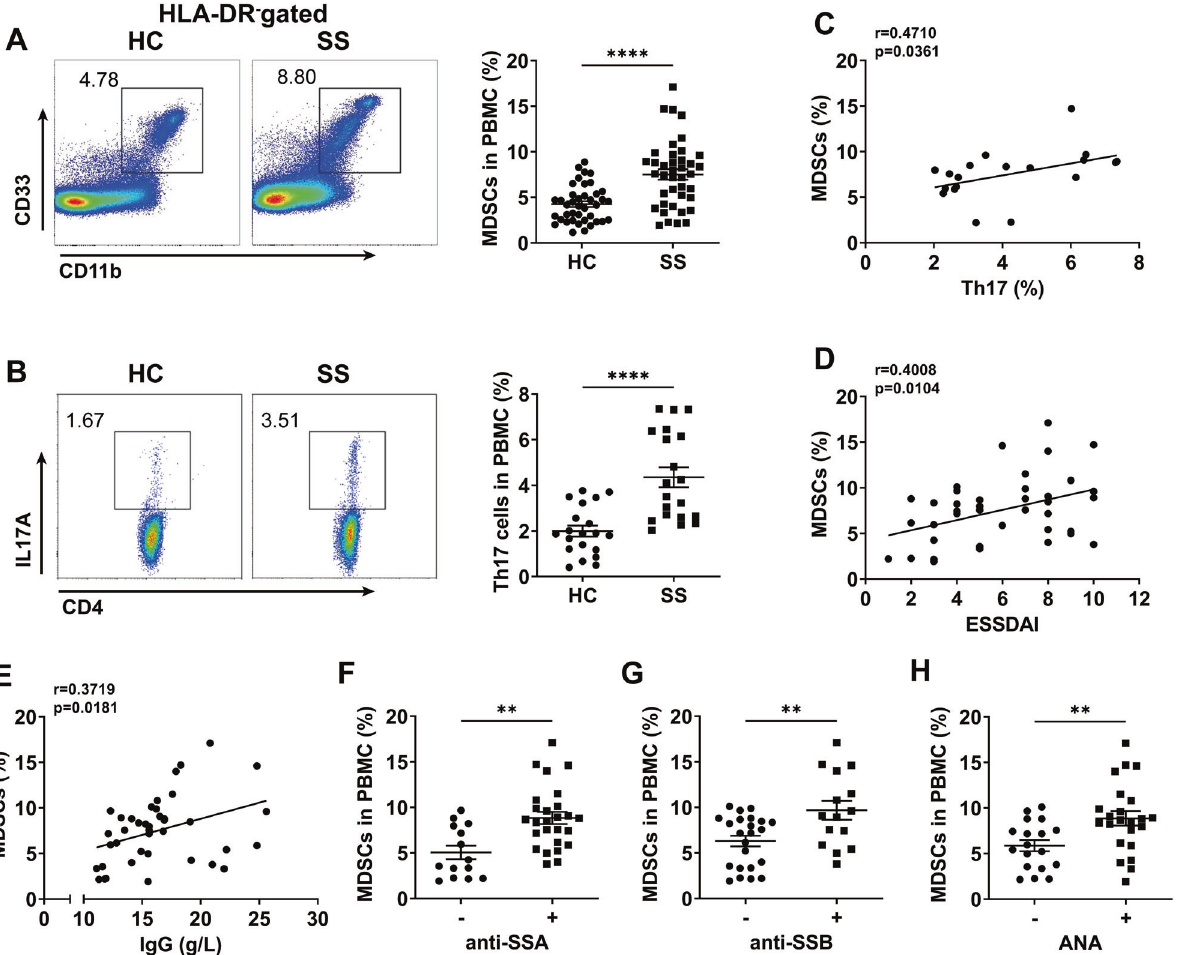
Fig. 1 Peripheral MDSCs from SS patients were positively correlated with the percentages of Th17 cells and disease activity. A , B Human peripheral HLA-DR - CD11b + CD33 + MDSCs and CD4 + IL-17A + Th17 cells (HC n = 40, SS n = 40) were detected by fl ow cytometry. Representative fl ow cytometric analysis and percentages of MDSCs in HC and SS patients were shown. C – E The relationships of MDSCs with Th17 cells, EULAR Sjögren ’ s Syndrome Disease Activity Index (ESSDAI) and serum IgG were analyzed ( n = 40). F – H SS patients were divided into antibodies-positive ( + ) and antibodies-negative ( – ) two groups, whose percentages of MDSCs were compared. ** p < 0.01, **** p <